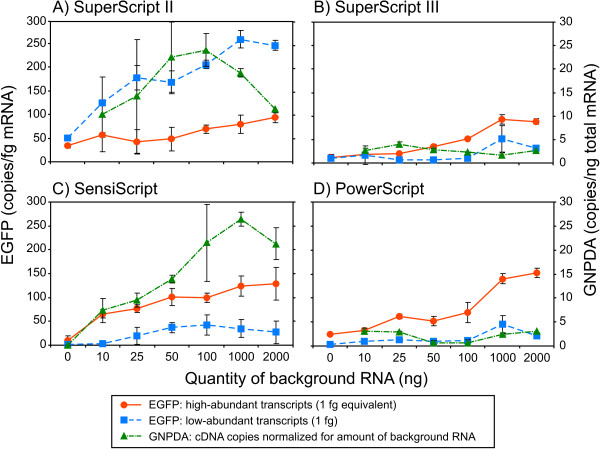
Influence of the background RNA the on detection of EGFP and GNPDA cDNAs. The high-abundance EGFP results were reported as 1 fg equivalent (i.e. divided by 1,000), whereas low-abundance EGFP results were uncorrected. Quantities of cDNA copies detected for GNPDA in total RNA (Table 2 and 3) were corrected for the amount of background RNA. Data for the SuperScript II, SuperScript III, Sensiscript, and PowerScript systems (panels A, B, C, and D, respectively) were plotted using the same scale for comparison purposes.